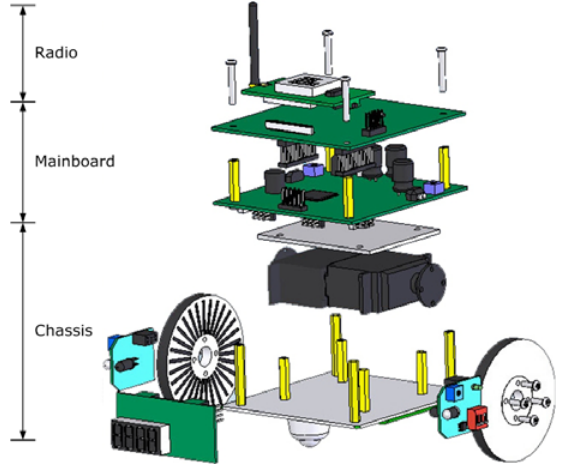
Figure 2. Exploded view of the proposed mobile node